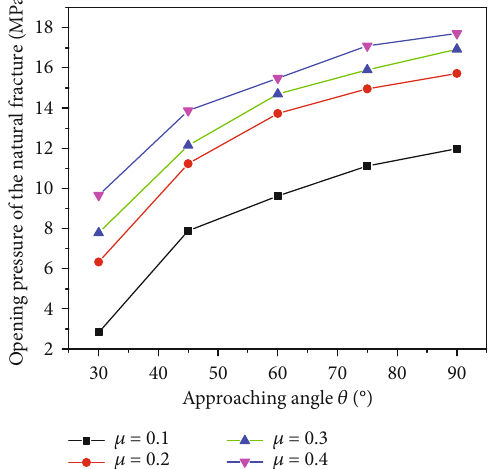
Figure 10: Opening pressure of the natural fracture under di ff erent elastic moduli.